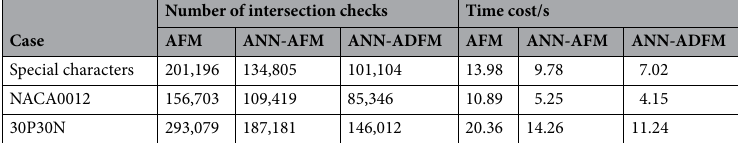
Table 2. Comparison of the time consumed by different methods to generate meshes.